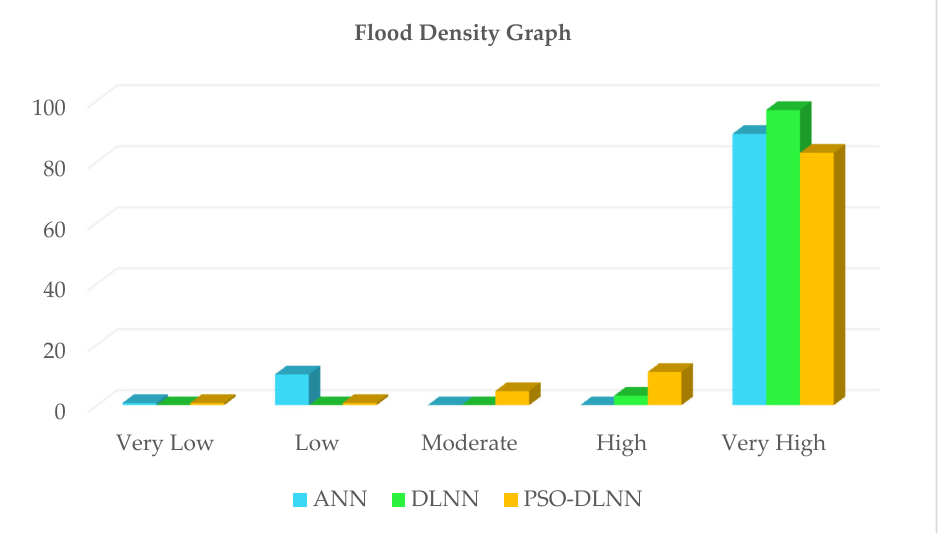
Figure 7. Flood density graph of ANN, DLNN, and PSO-DLNN. Table 6 represents the evaluation of ANN, DLNN, and optimized PSO-DLNN model- ing against sensitivity, specificity, TSS, and AUC metrics. The sensitivity test for the ANN model obtained the values of 0.98 and 0.94 for training and validation, respectively. Both DLNN and PSO-DLNN models slightly acquired the highest values of sensitivity